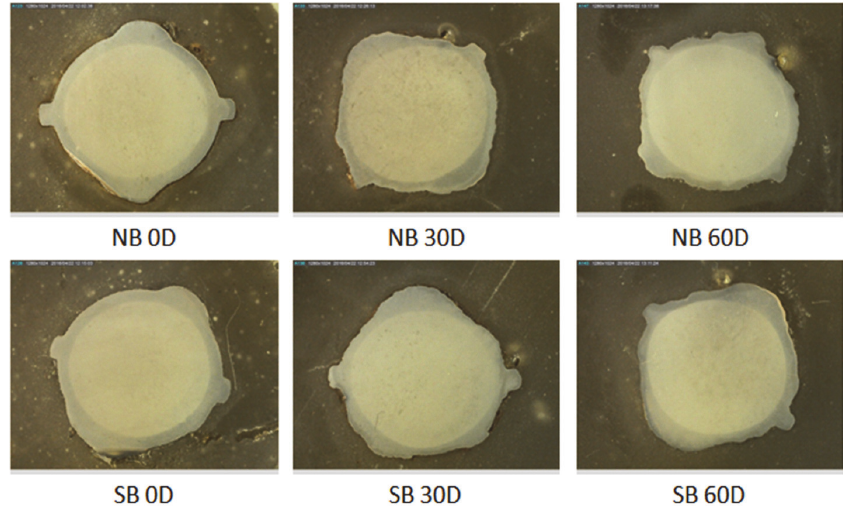
Figure 6: Martensitic area reduction with time of